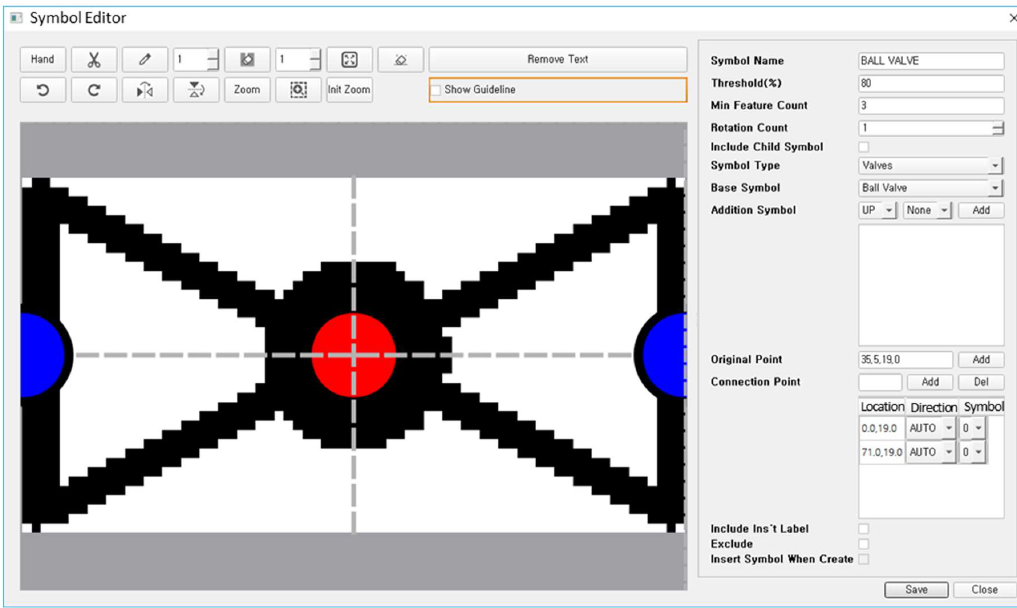
Figure 3. An example of symbol registration .